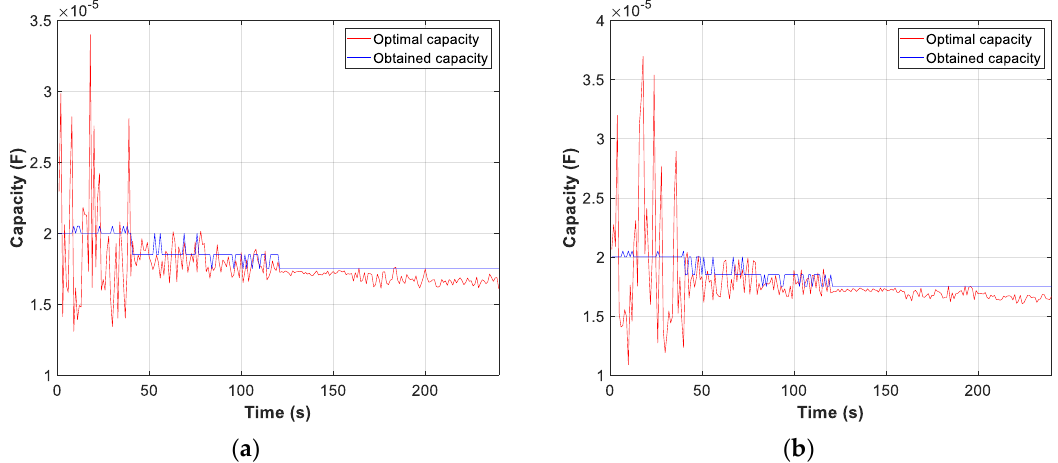
Figure 13. Comparison obtained vs optimal capacity: ( a ) Metal halide; ( b ) Sodium vapour.